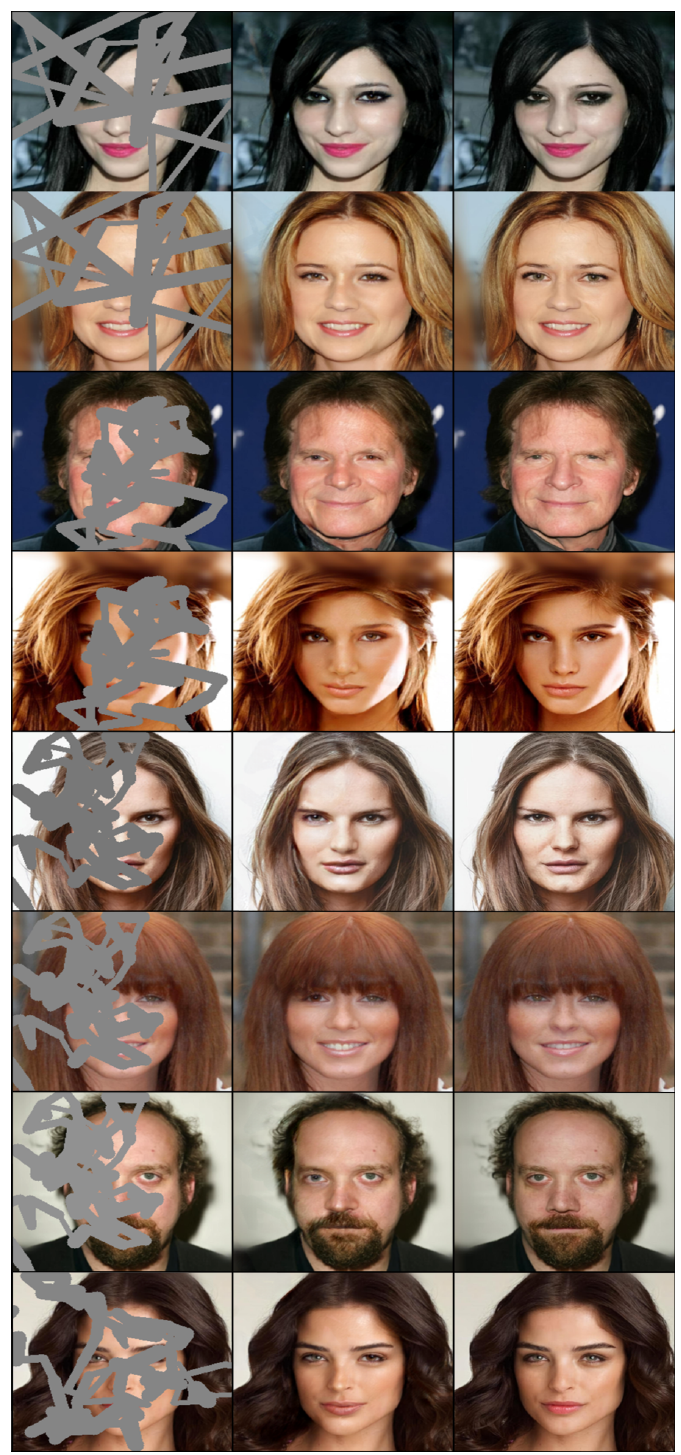
Figure A3. More results on CelebA-HQ dataset [23]. From left: input image, inpainted image, and respective ground